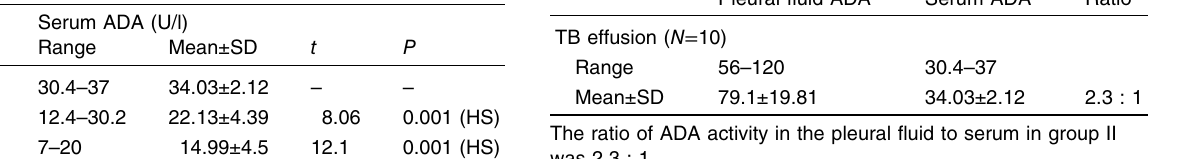
Table 6 Comparison between group II versus other groups as regard serum ADA